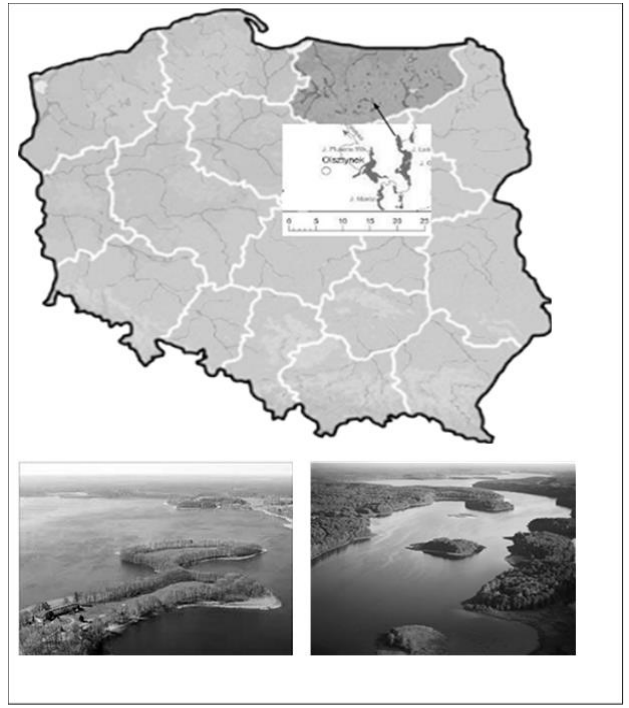
Figure 1. Study area was located in northeastern Poland, near the city Olsztyn (geographical coordinates: 53˚58’60’’N, 20˚48’08’’E). Table 1. Biometric parameters, BCF and differences between the content of mercury in the same organs of fish examined (mg/kg wet weight).